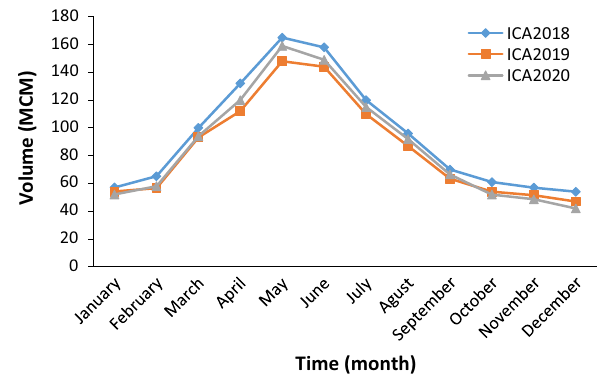
Fig. 14 The required storages of the reservoir during